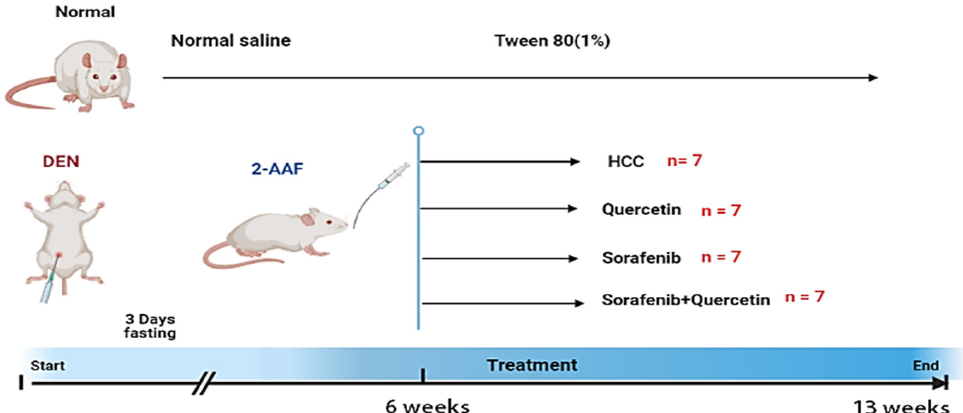
Figure 1. Induction of HCC and quercetin/sorafenib treatment. Diethylnitrosamine (DEN) was used as the beginning agent of carcinogenesis. Following that, 2-animofluorene (2-AAF) was given as a promoting agent. All animals were euthanized after six weeks of post-carcinogenic treatment.